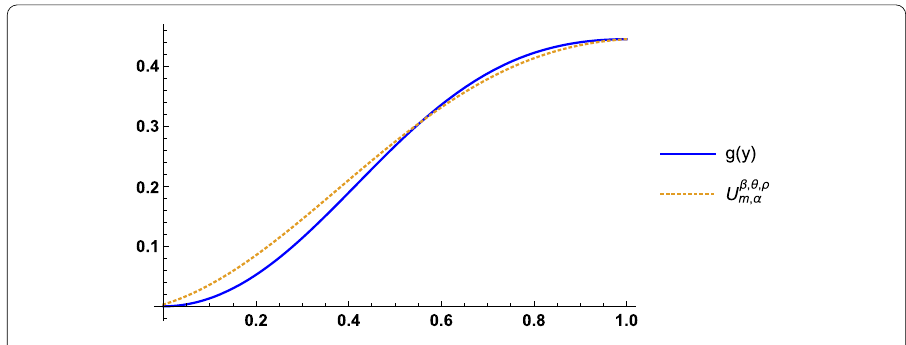
Figure 3 Approximation of